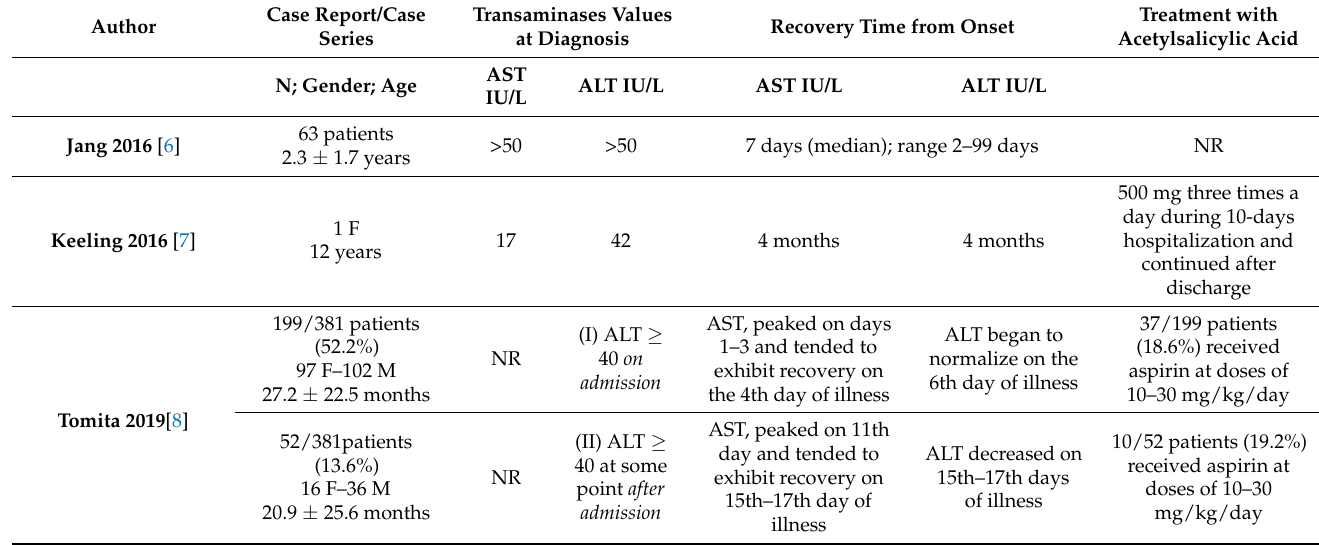
Table 1. Natural recovery time of liver enzymes abnormalities in Kawasaki